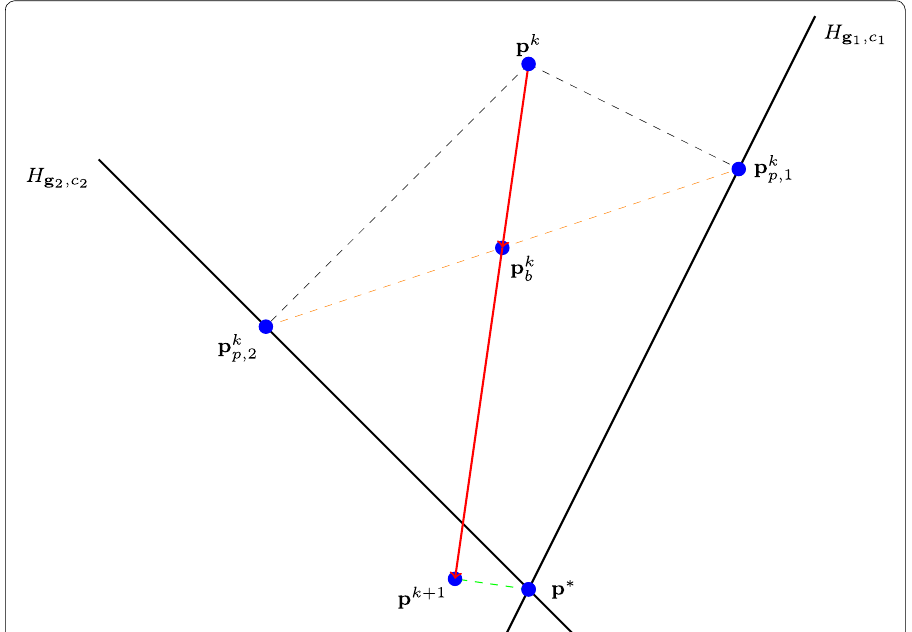
Fig. 3 Visualisation of Scolnik’s acceleration. The optimal line search parameter α ∗ yields the new iterate p k + 1 . Due to the construction of Scolnik’s acceleration, the